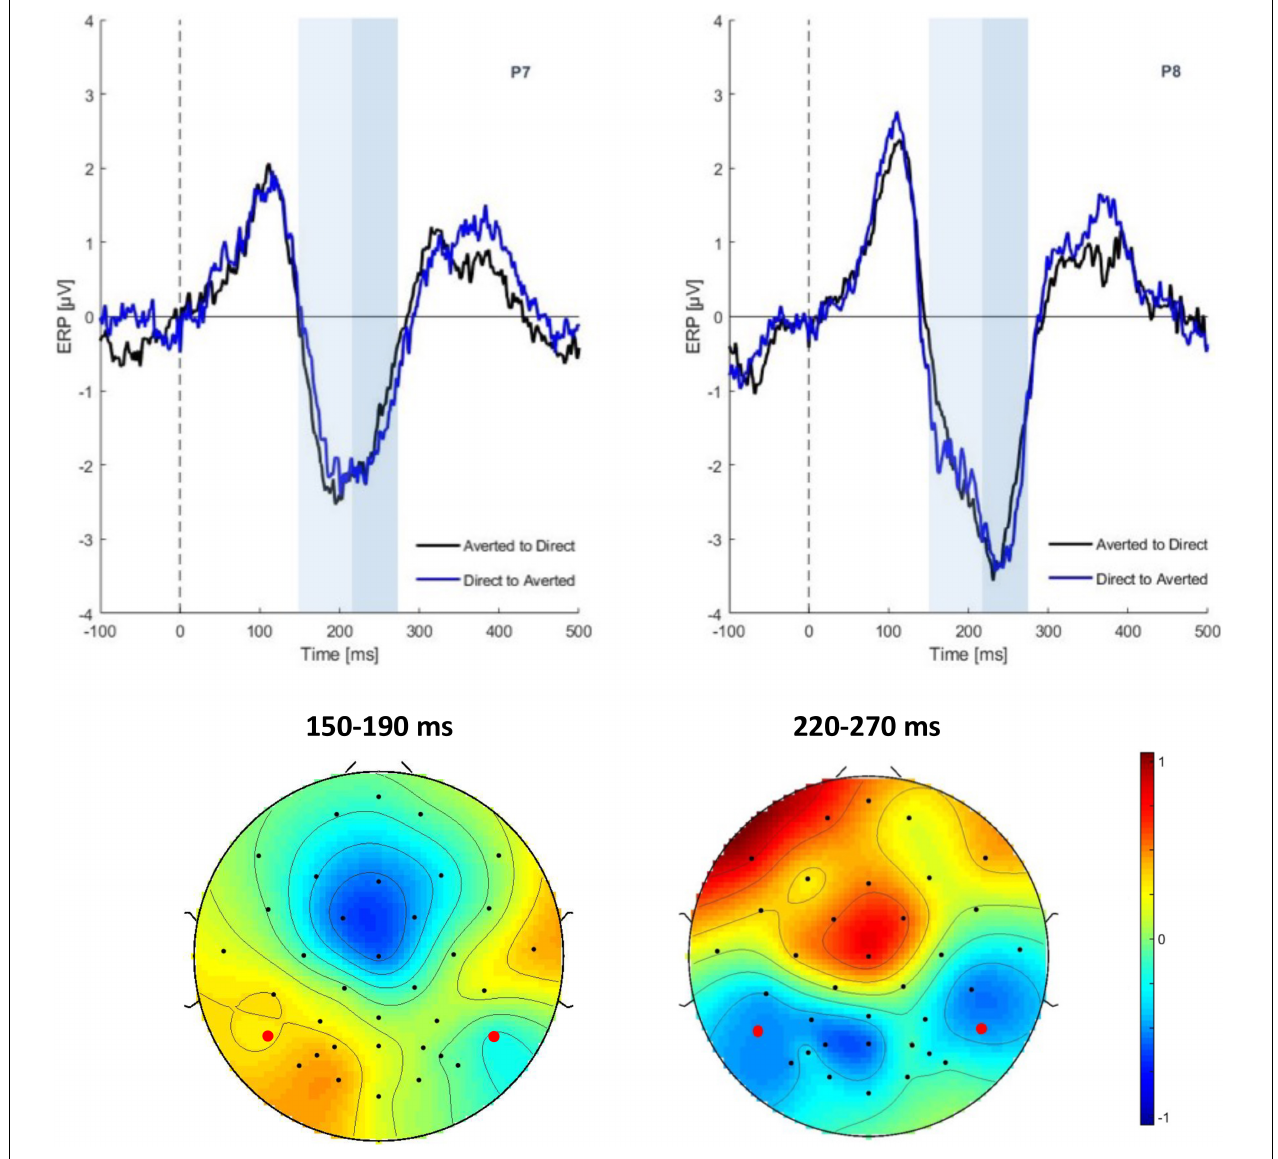
FIGURE 3 | Grand average ERPs in the CHANGE interval. Top : ERP waveform of gaze conditions at electrode P7, P8. Bottom : Scalp topographies of the gaze effect (ERPs in the direct to averted condition minus the averted to direct condition) in the time segments 150–190 ms (ns) and 220–270